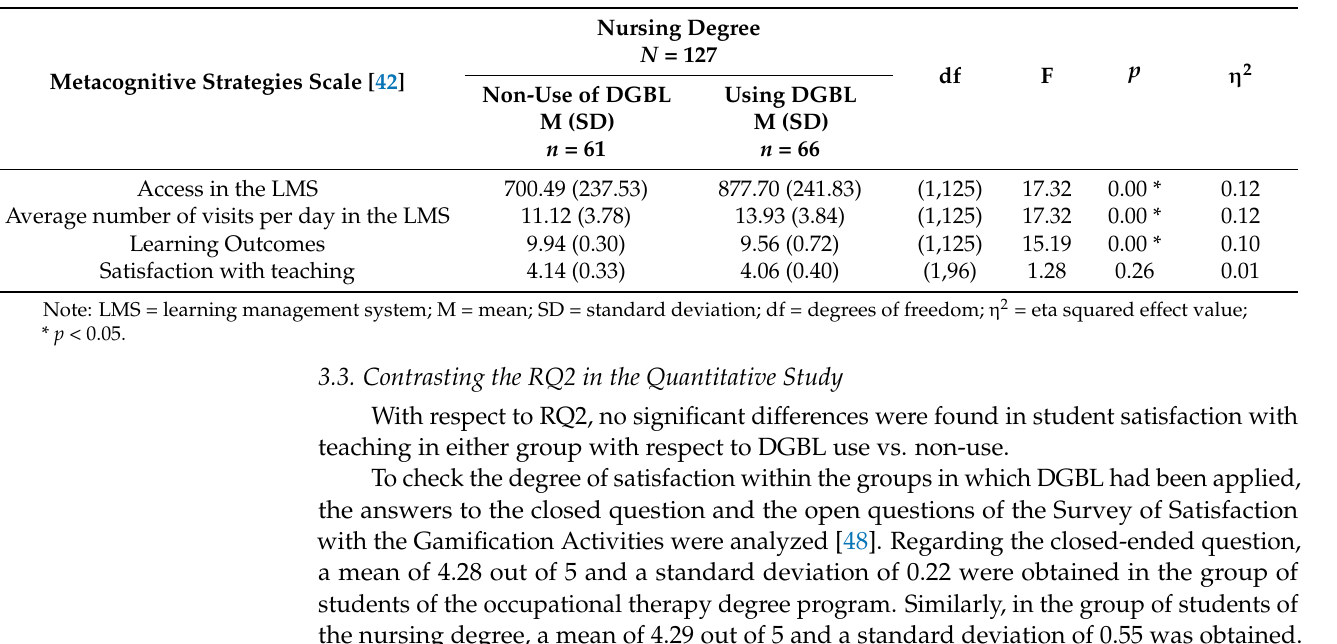
Table 5. ANOVA of a fixed effects factor (use of DGBL vs. non-use) in the group of nursing students.